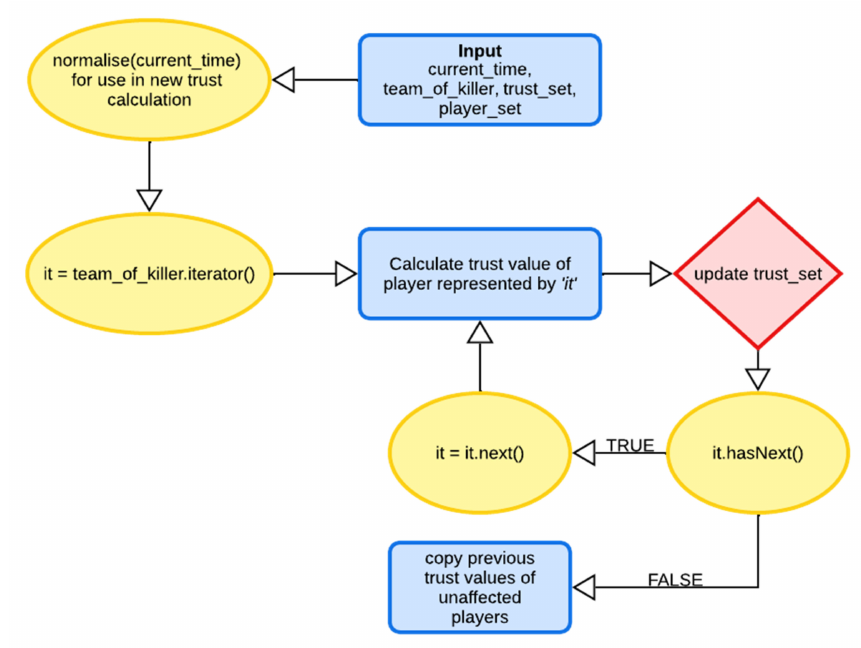
Figure 7. Flow of the trust evaluation module.